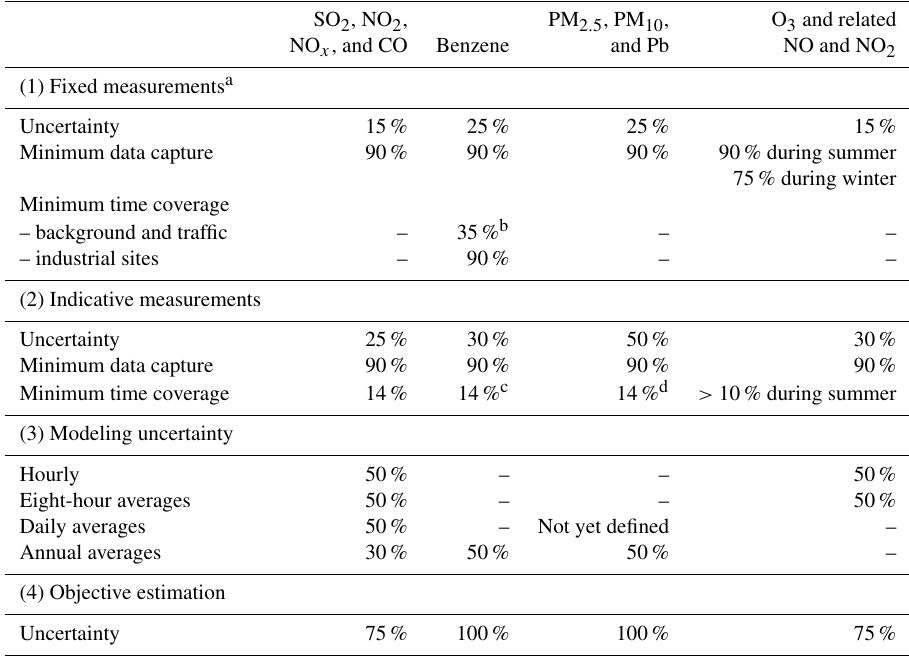
Table 1. Current Ambient Air Quality Directive (AAQD) observation modes and their measurement uncertainties adapted from the AAQD (European Council,